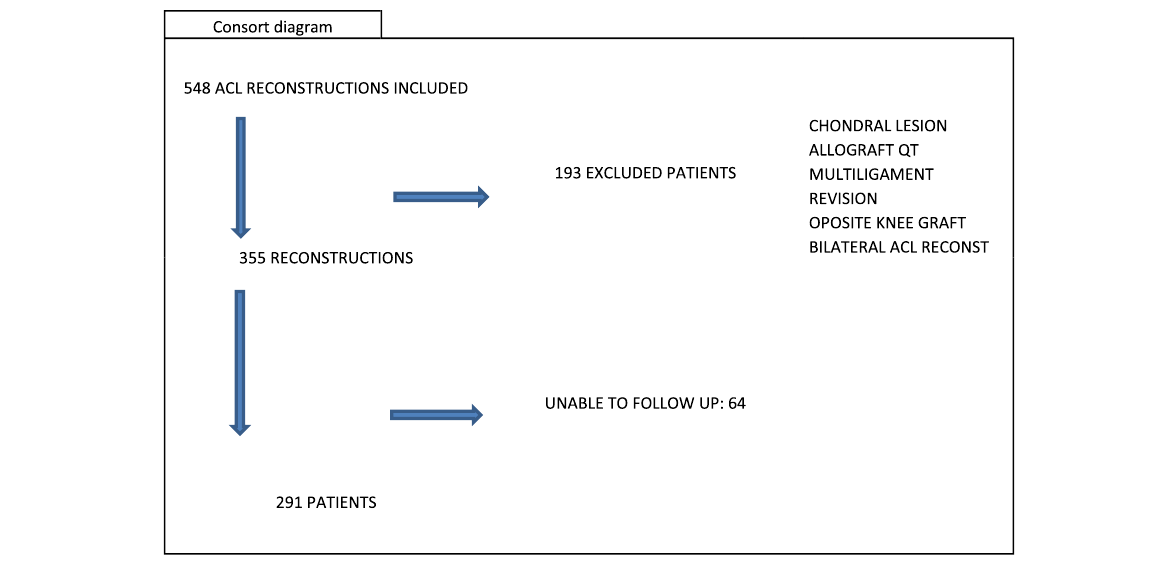
Fig. 6 Consort Diagram. Inclusion and exclusion